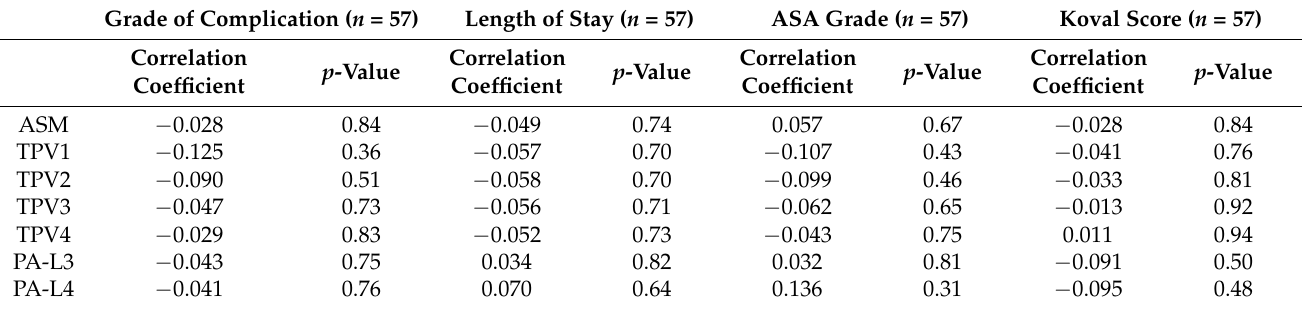
Table 4. Spearman correlation test between psoas muscle volume, cross-sectional area, ASM, and grade of complication/ASA grade of physical status/Koval score. Pearson correlation test between psoas muscle volume, cross-sectional area, ASM, and length of hospital